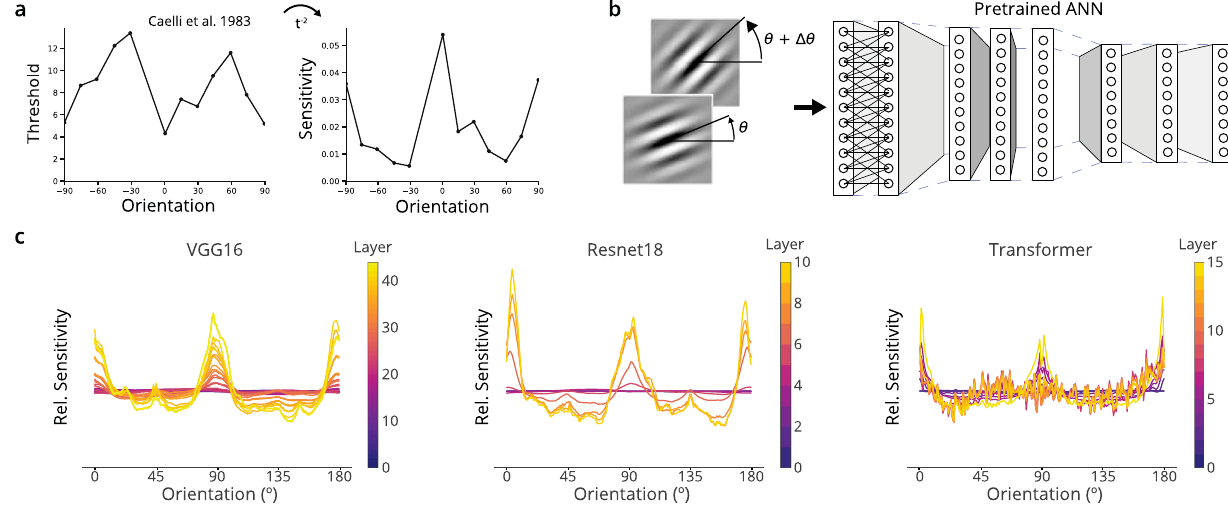
Fig. 2 | Arti fi cial neural networks trained to classify naturalistic images show similar patterns of sensitivity as humans. a Discrimination thresholds for orientation vary systematically in humans. The sensitivity of the underlying inter- nalrepresentations,astheFisherInformation,canbeinferredastheinversesquare ofthethreshold 6,9 .Datafromref.44. b Wemeasuredthesensitivityofeachlayerin